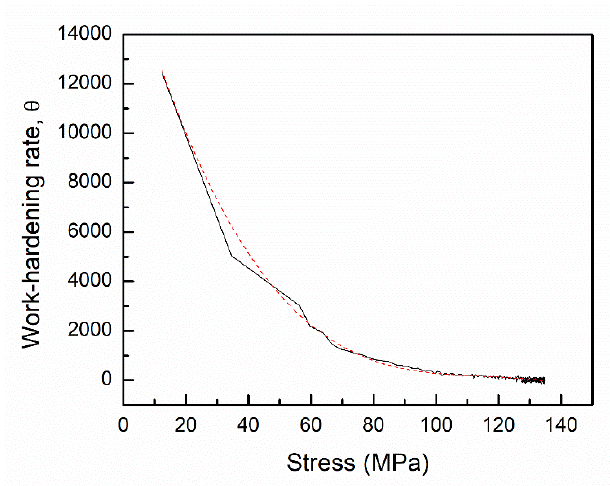
Figure 17. The experimental (black solid line) and fitted (red dashed line) θ–σ curves for the sample deformed at 900 °C, with a deformation rate of 0.01 s −1 .